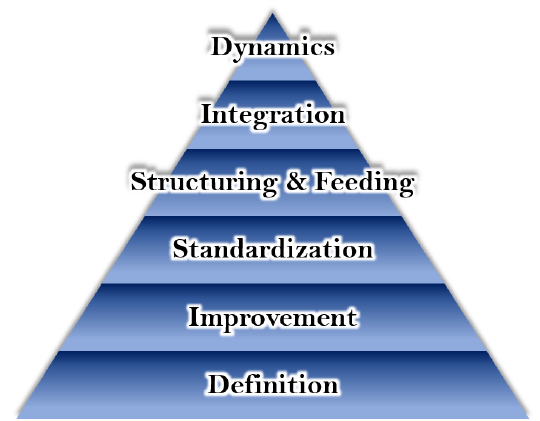
Figure 5. Maturity echelons of the data system